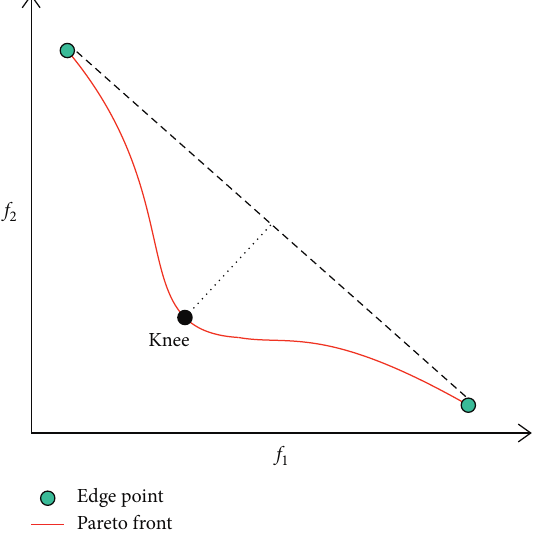
Figure 1: Illustration of knee